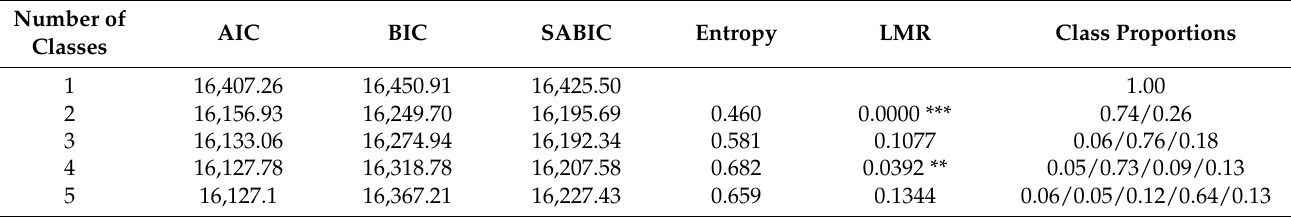
Table 3. Model fit. AIC: Akaike information criteria; BIC: Bayesian information